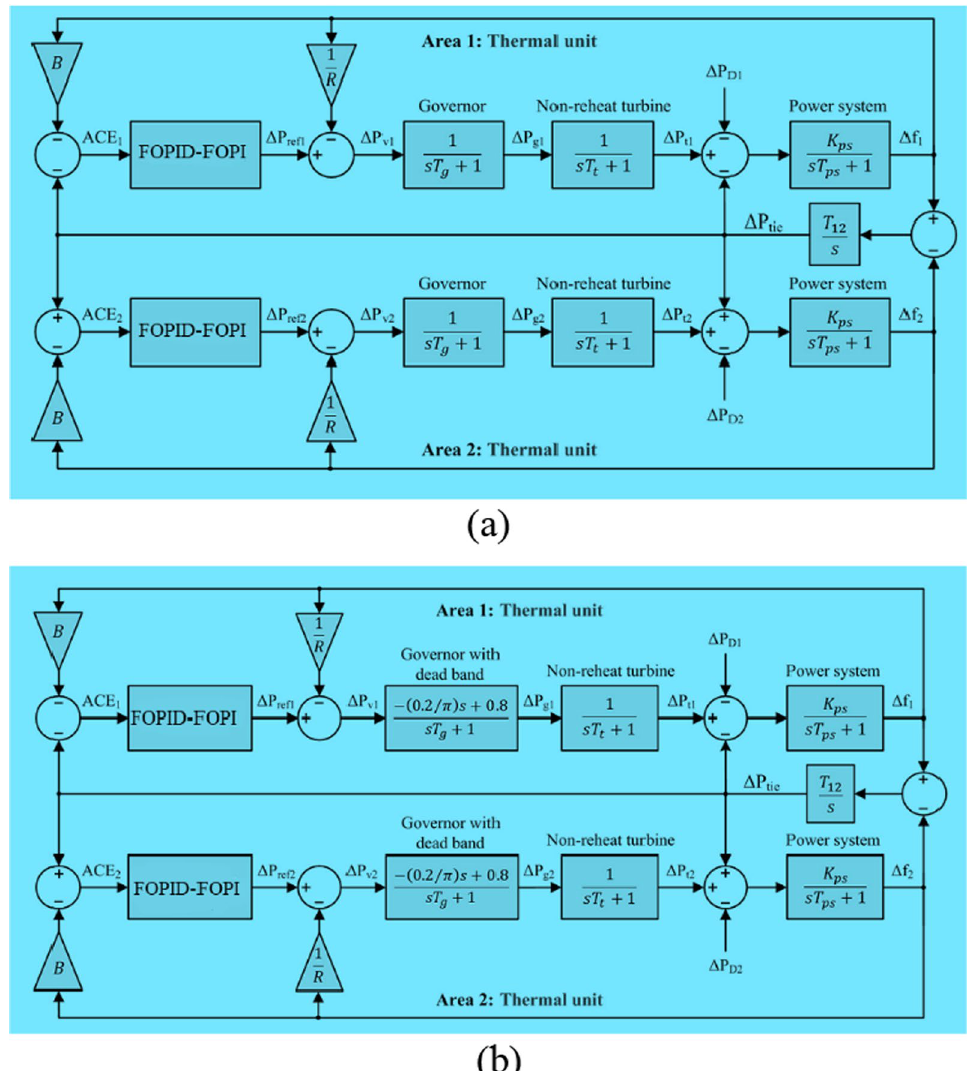
Fig. 1 TF model of the two-area nonthermal unit: a without GDB (Test-system 1) and b with GDB (Test-system